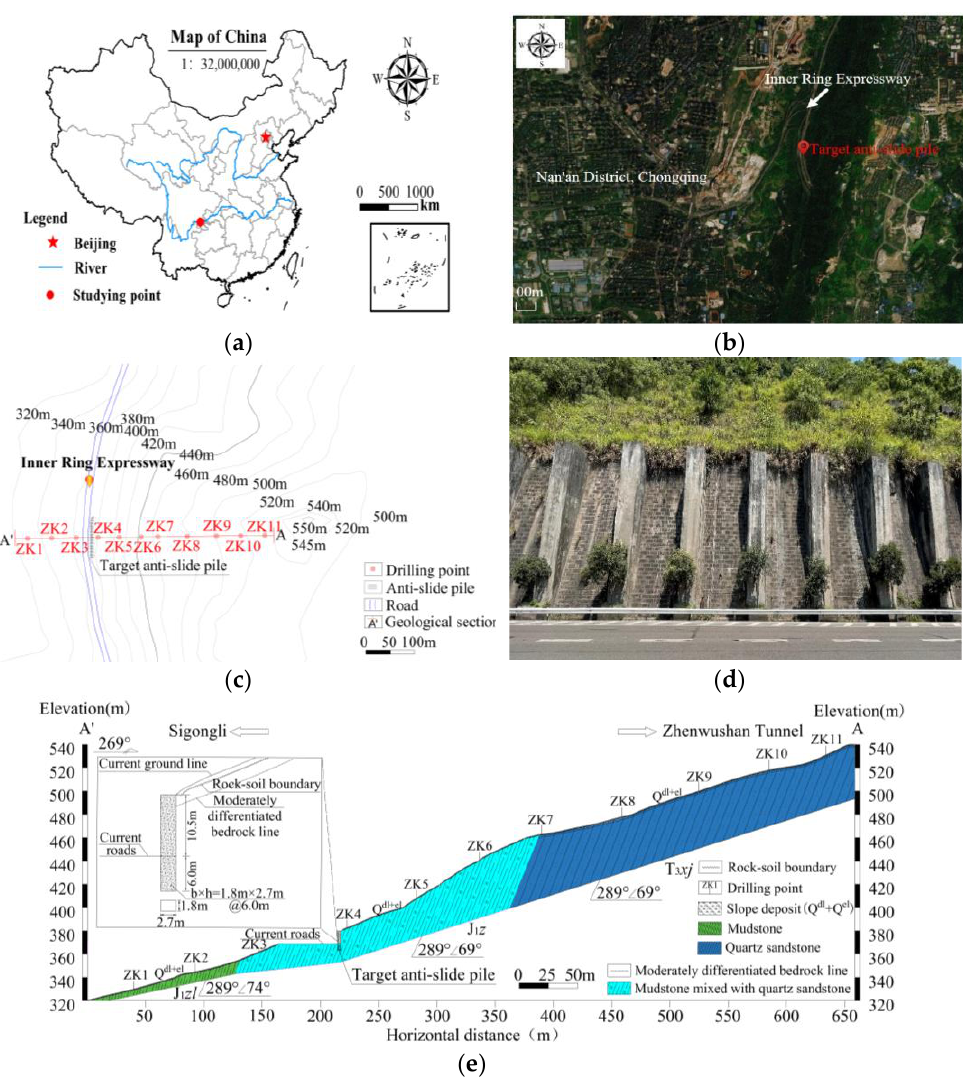
Figure 1. Basic information of the target anti-slide pile. ( a ) Location; ( b ) geographic location; ( c ) topographical map; ( d ) realistic picture; ( e ) engineering geological profile.